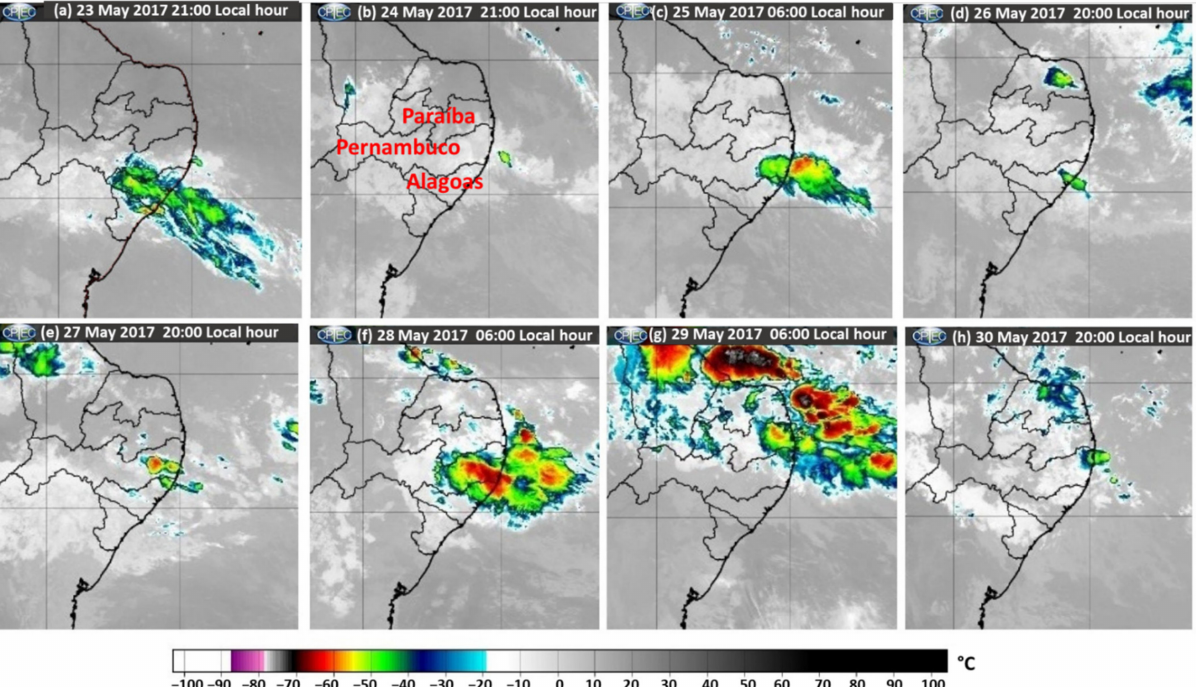
Figure 9. GOES-16 satellite images in the cloud top channel and highlighted for the period from 23 to 30 May 2017 at the ECNEB during the action of the rainfall system. The information corresponds to 23 ( a ), 24 ( b ), 25 ( c ), 26 ( d ), 27 ( e ), 28 ( f ), 29 ( g ) and 30 ( h ) May